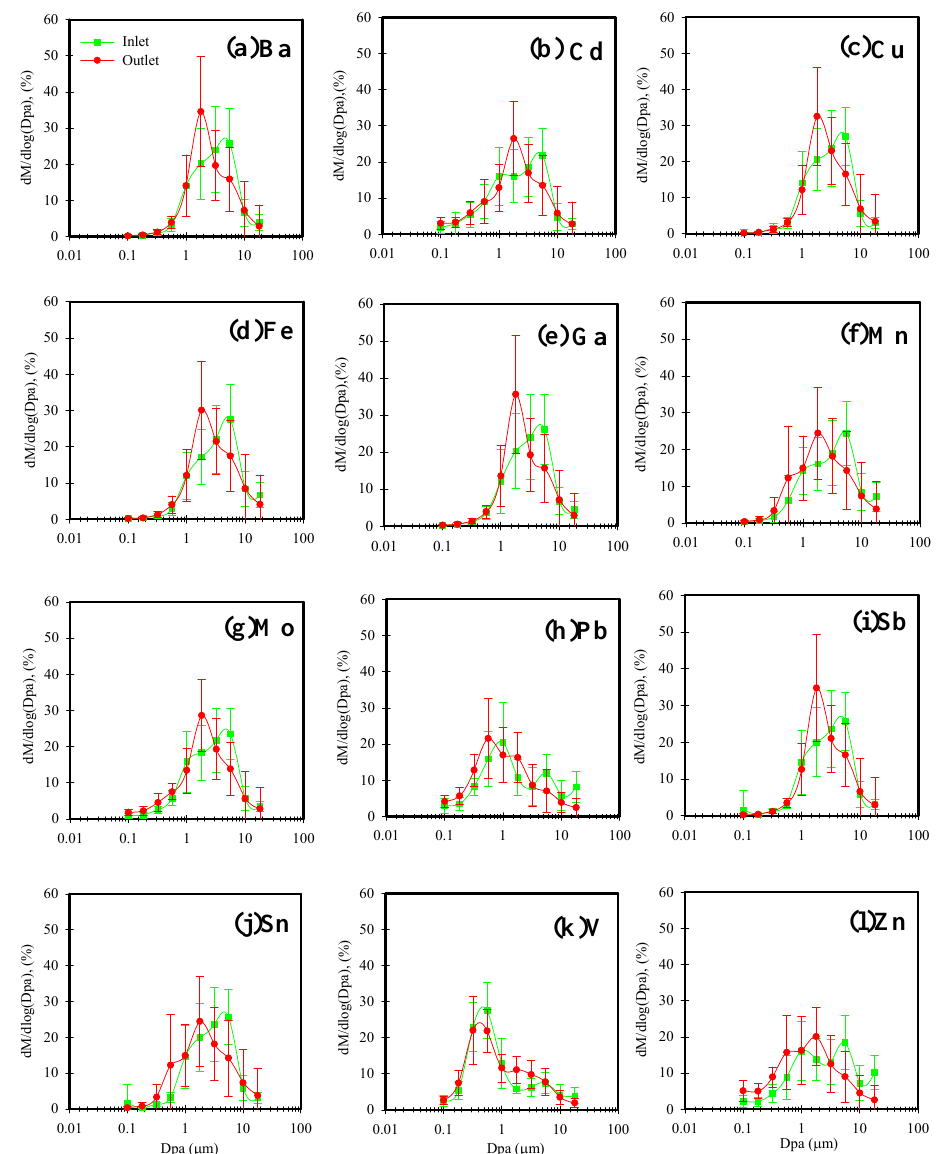
Figure 2. Average size distributions of traffic-derived elements observed at the inlet and outlet sites inside Hsuehshan